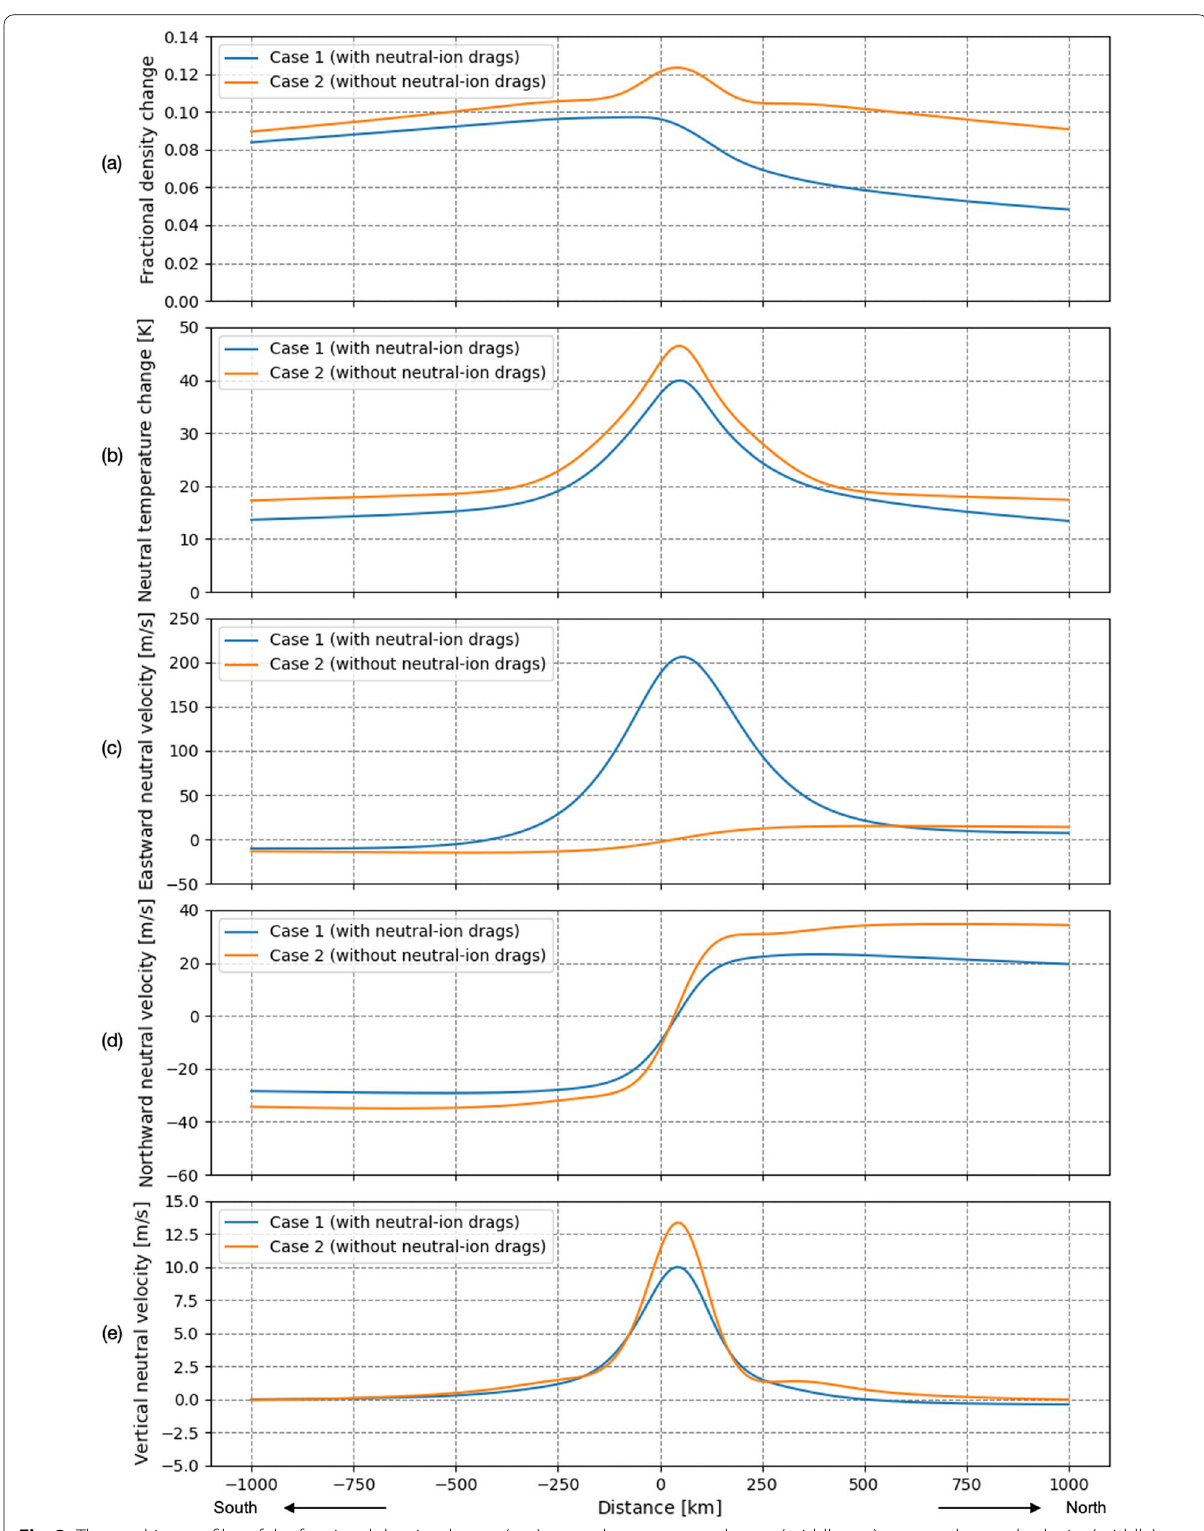
Fig. 3 The resulting profiles of the fractional density change (top), neutral temperature change (middle top), eastward neutral velocity (middle), northward neutral velocity (middle bottom), and vertical neutral velocity (bottom) at the 400-km altitude in each case. Positive distance is directed to the northward. The peak of electron precipitation is located at the